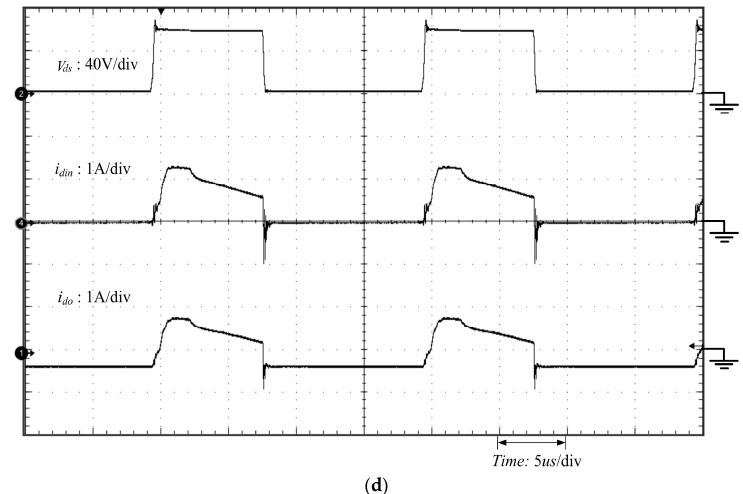
Figure 9. Experiment waveform under full-load P o = 150 W. ( a ) Measured waveforms of V ds , i Lk and i s ; ( b ) Measured waveforms of V ds , i d 1 and i d 2 ; ( c ) Measured waveforms of V ds , i d 3 and i d 4 ; and ( d ) Measured waveforms of V ds , i din and i do .